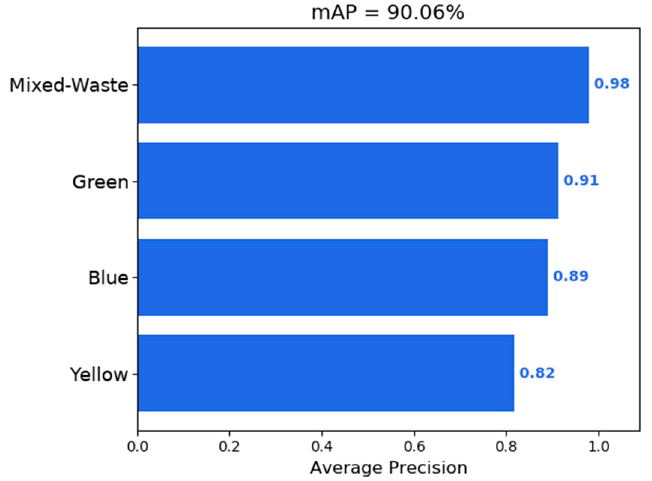
Figure 6. The mAP per object class after detection.